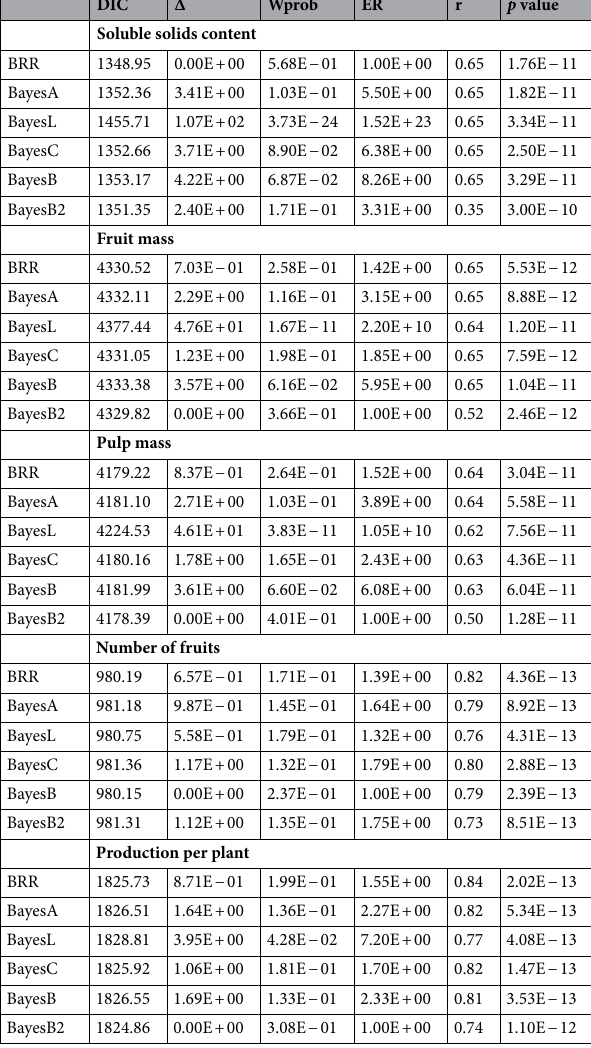
Table 1. Adjustment quality of six Bayesian models: BL, BRR, BayesA, BayesC, BayesB, and BayesB with π = 1e − 5 (BayesB2) to associate SSR markers and phenotypic data in P. guajava in the traits of soluble solids content, fruit mass, pulp mass, number of fruits per plant and production per plant. The bias values were obtained by eight-fold cross-validation (88% of the data for training and 12% for validation), in the same sample sets for each model. DIC = deviance information criterion; Del (delta) = difference between the highest and the lowest DIC value; Wprob = posterior probability model; ER = evidence ratio; Error = error attributed to Wprob; r = correlation between predicted by the model and reserved validation data; p value = significance of the